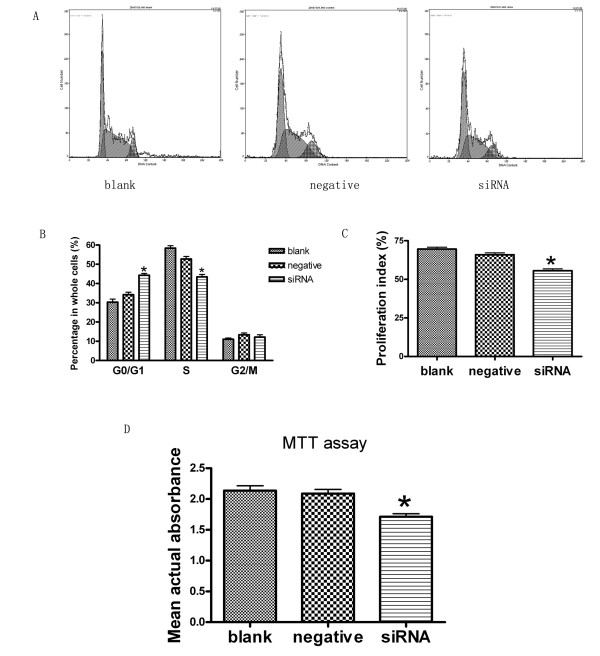
Knock down of JMJD2A resulted in cell cycle change and proliferation inhibition. A. DNA contents of MDA-MB-231 cells treated in blank control group, negative control group and siRNA group by FCM. B. Column diagram analysis for the percentages of cells at each phase in three different groups: G0/G1 phase, S phase and G2/M phase. At G0/G1 phase, there was a significant difference in the percentage of cells in siRNA group compared with blank control group and negative control group respectively. At S phase, there was a significant difference in the percentage of cells in siRNA group compared with blank control group and negative control group respectively, while no significant differences in the percentages of cells at G2/M phase in the three groups. C. Column diagram analysis for the proliferation indexes (PI) calculated in three different groups. PI in siRNA group was significantly lower than that in blank control group and negative control group respectively. D. Column diagram analysis for the actual absorbance of three different groups, the mean actual absorbance of siRNA group was significantly lower than that of the blank control group and the negative control group, respectively. (*P < 0.05, compared with blank control group and negative control group respectively)